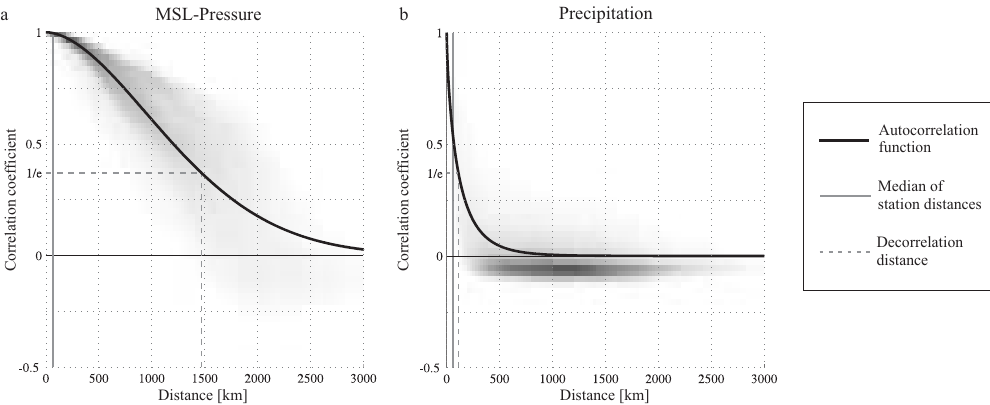
Fig. 3. Comparison of the autocorrelation for the parameters MSL-pressure (a) and precipitation (b) as a function of the station distances based on the hourly measurements of June 2011. The correlation is presented by the adjusted analytical autocorrelation function (black bold line). In addition to the decorrelation distance (gray dashed line), the median of all distances between neighboring stations is marked by a gray vertical line. Whereas in (a) the median of station distances is small compared to the decorrelation distance, in (b) they are of comparable